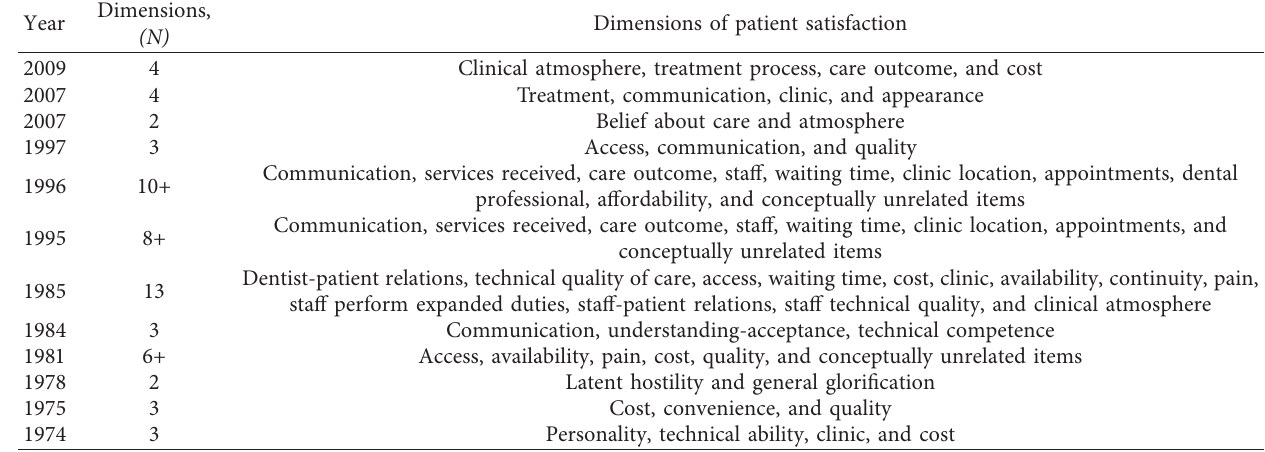
Table 1: Dimensions of tools used for appraising patient-satisfaction in healthcare in descending order of time appearance (adapted from Nair et al.